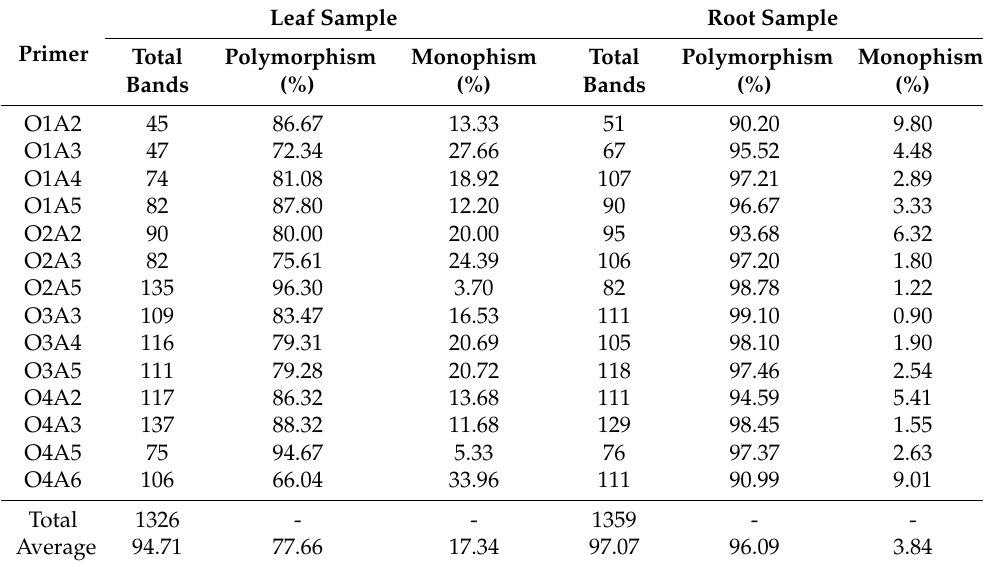
Table 1. DDRT-PCR amplified results with primer combinations of cDNA from leaf and root of four oil palm varieties at different water deficits. Leaf Sample Root Sample Primer